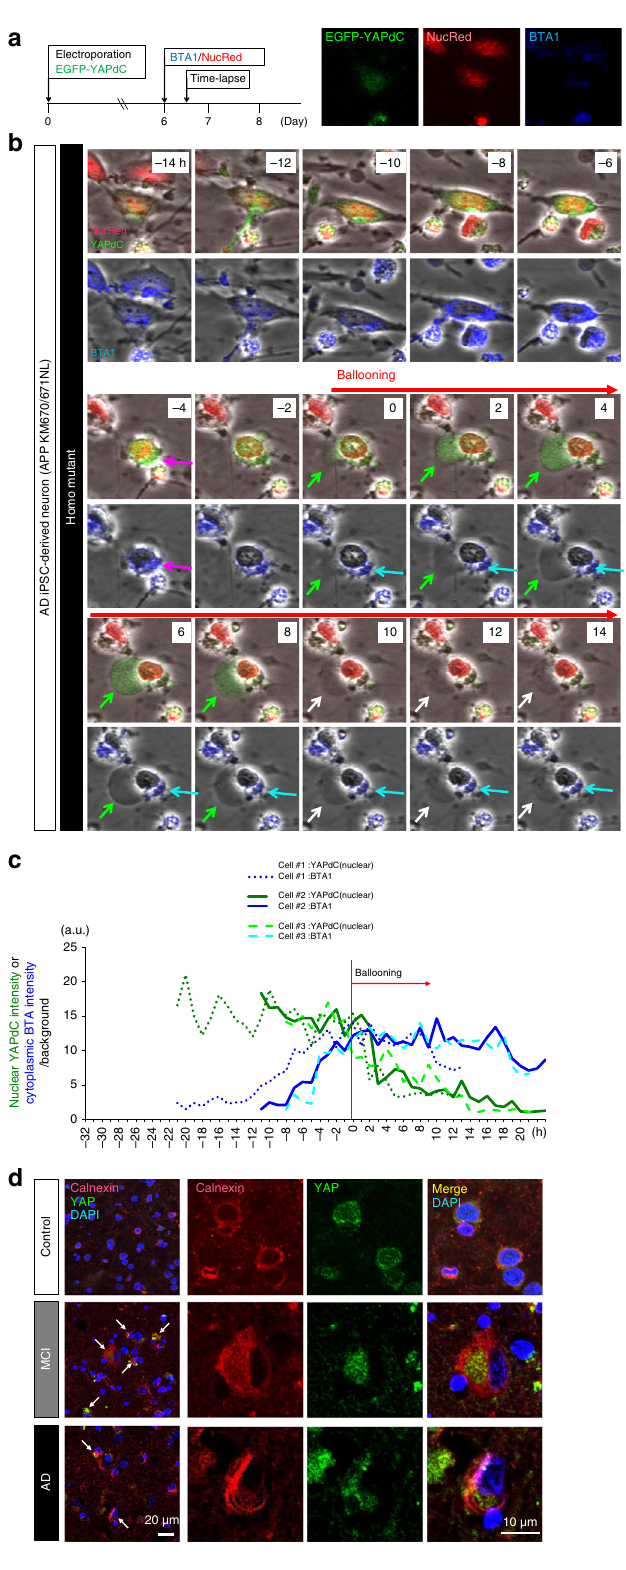
tured on Lab-Tek II chambered coverglass coated with poly-L-ornithine (P3655, Sigma-Aldrich, St. Louis, MO, USA) and laminin (23016015, Thermo Fisher Sci- USA). After differentiation to neurons for seven days, time-lapse images of pTEAD-driven mCherry and pCMV-driven EGFP were acquired by Olympus FV10i-W (Olympus, Tokyo, Japan) at 30 min intervals for 36 h. Cells were co-